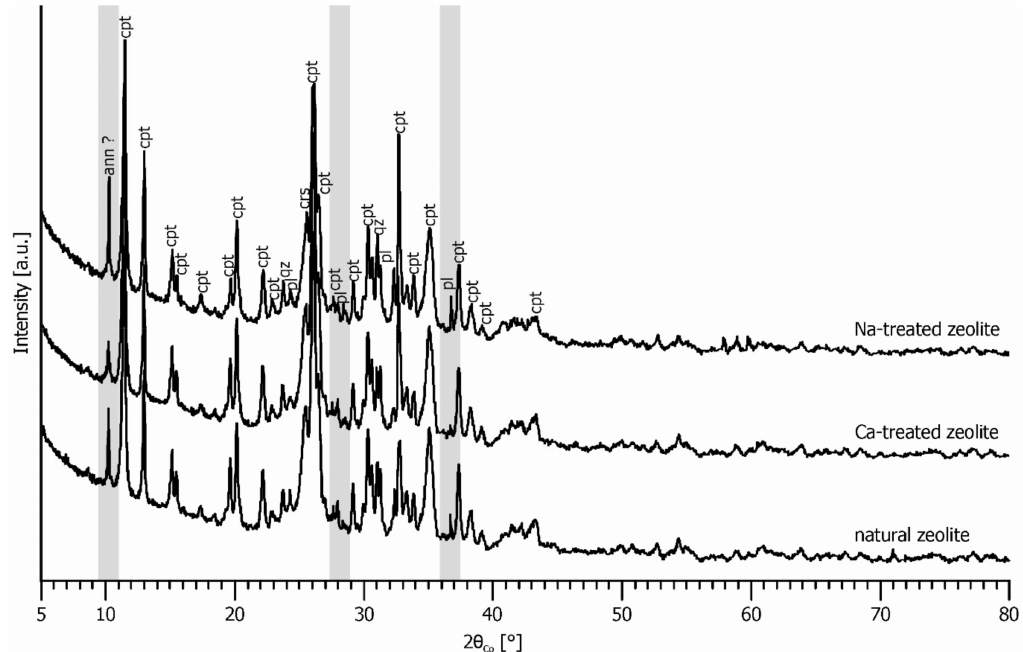
Figure 2. X-ray di ff raction (XRD) patterns of zeolites with di ff erent cation loading (ann: annite, cpt: clinoptilolite, pl: plagioclase, qz: